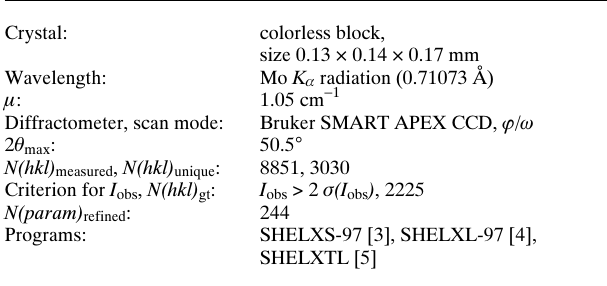
Table 1. Data collection and